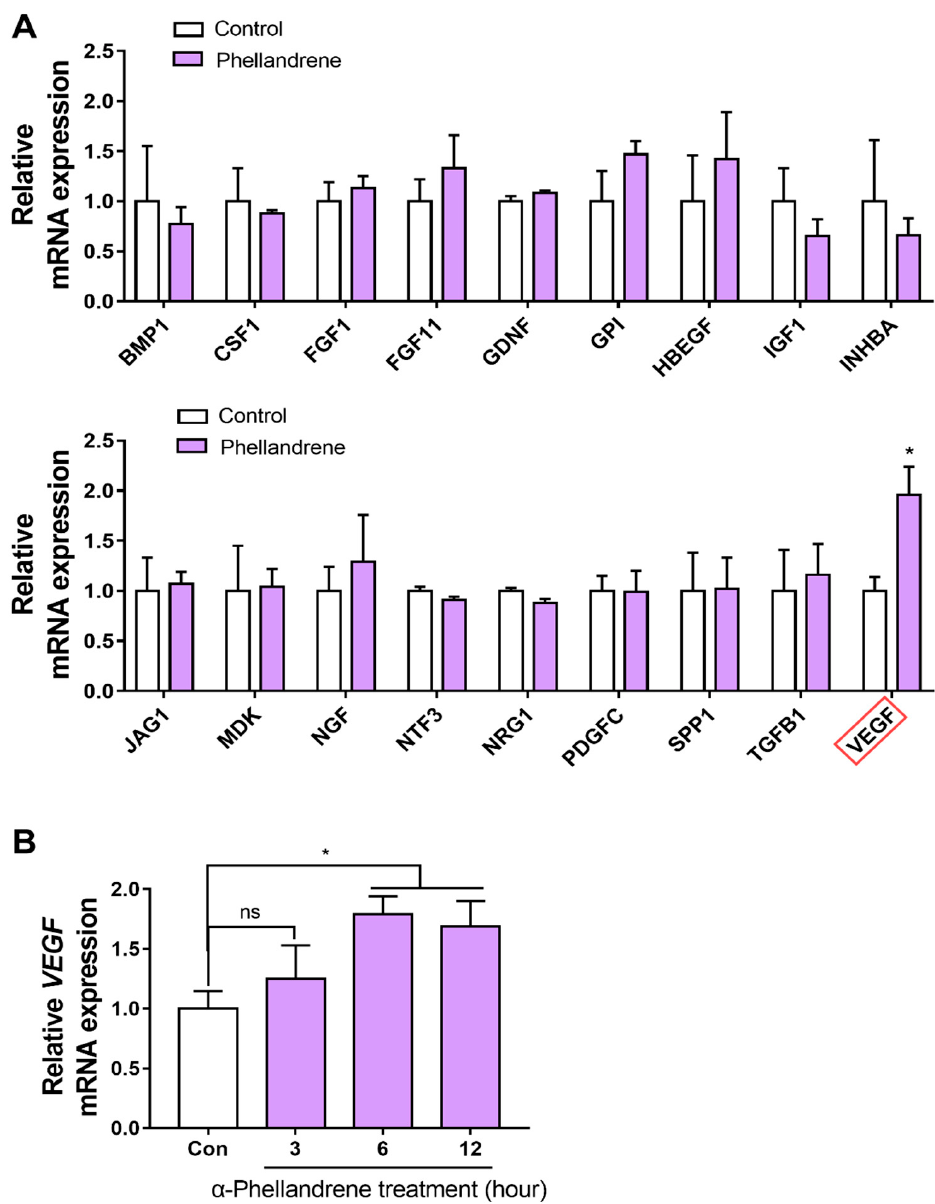
Figure 5. α -phellandrene increases vascular endothelial growth factor (VEGF) gene expression in dermal papilla cells (DPCs). ( A ) DPCs were either treated with vehicle (dimethyl sulfoxide; DMSO) or 12.5 µ M of α -phellandrene for 6 h. Then, mRNA was extracted and quantitative polymerase chain reaction (qPCR) analyses were performed for detecting the altered expression of eighteen growth factor genes as potential target genes of cAMP-responsive element-binding (CREB) protein. Data were normalized relative to glyceraldehyde 3-phosphate dehydrogenase (GAPDH) expression in each sample and expressed relative to the control value (vehicle). Gene abbreviations are as follows: bone morphogenetic protein 1 ( BMP1 ), colony stimulating factor 1(CSF1), fibroblast growth factor 1 ( FGF1 ), fibroblast growth factor 11 ( FGF11 ), glial cell derived neurotrophic factor ( GDNF ), glucose- 6-phosphate isomerase ( GPI ), heparin binding epidermal growth factor- like growth factor ( HBEGF ), insulin-like growth factor 1 ( IGF1 ), inhibin subunit beta A ( INHBA ), notch ligand jagged-